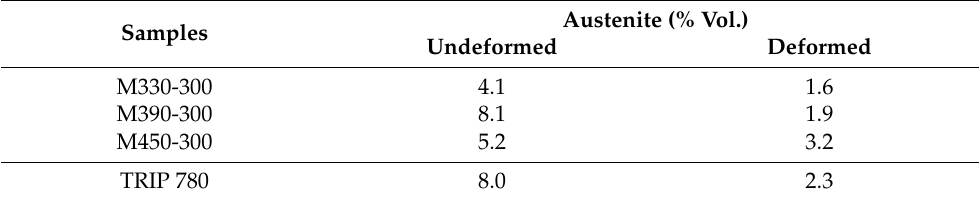
Table 6. Retained austenite of deformed and undeformed